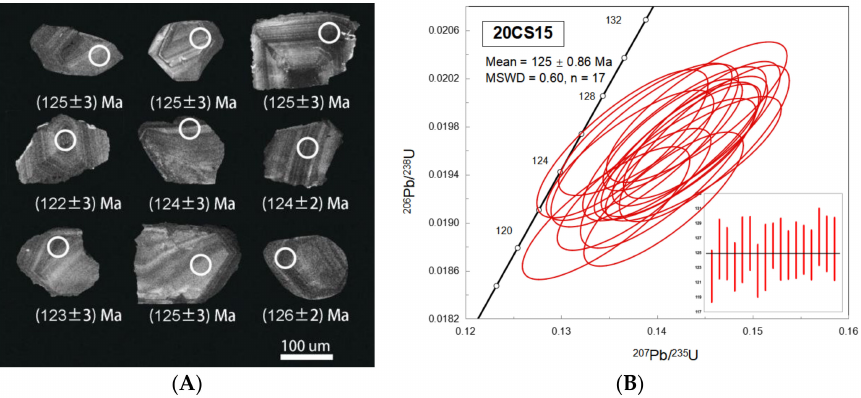
Figure 8. ( A ) CL image of zircon grains from lamprophyre sample 20CS15. ( B ) Zircon U-Pb concor- dant plot for the lamprophyre sample